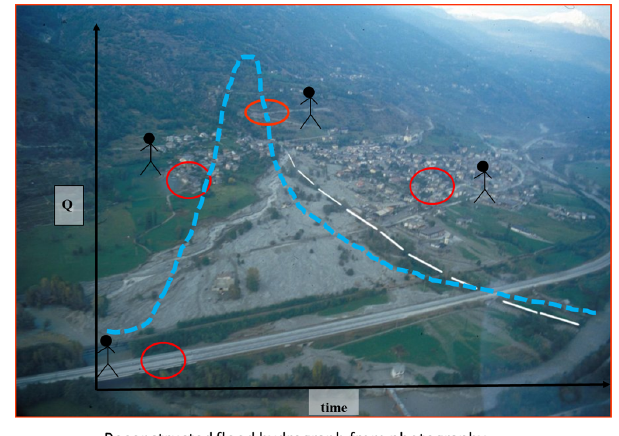
Fig. 5. Possible reconstruction of the various stages of a flood hy- drograph in the Alps via stakeholder knowledge. Stakeholders can be involved by producing photos and observations from tributaries and flood plains in areas with clear landmarks during the course of a